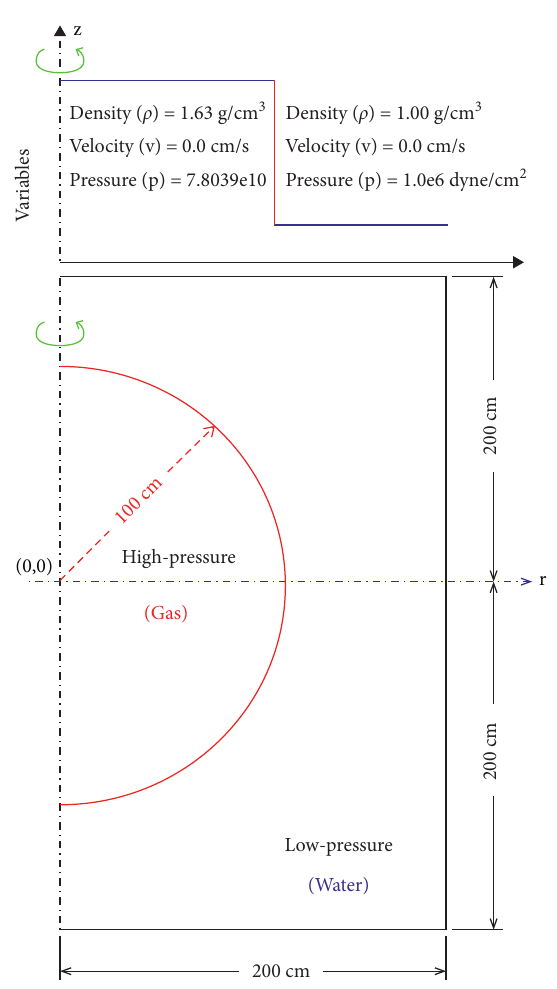
Figure 12: Initial conditions of Case 4.